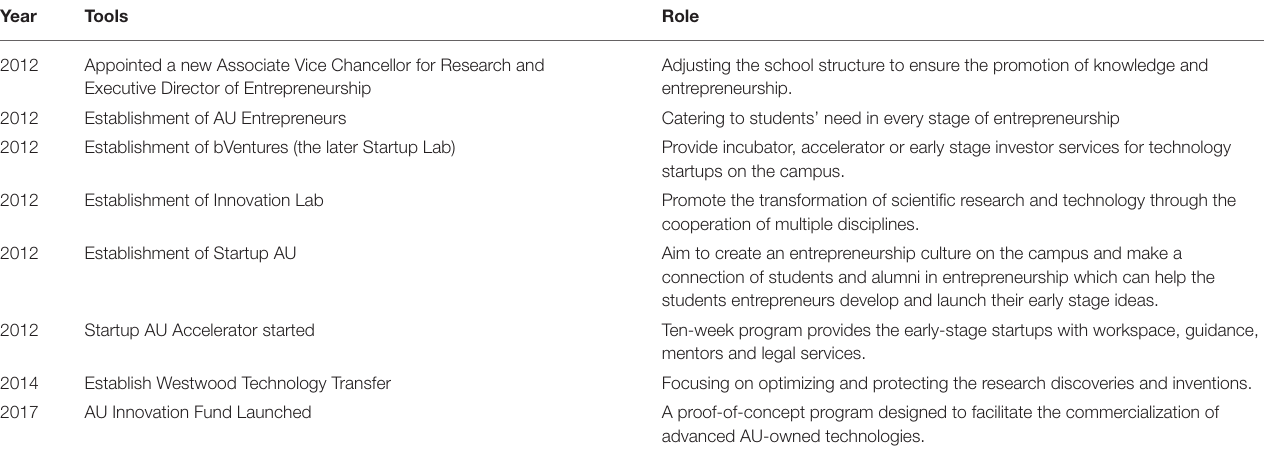
TABLE 2 | Timeline of the establishment of the entrepreneurship organization in